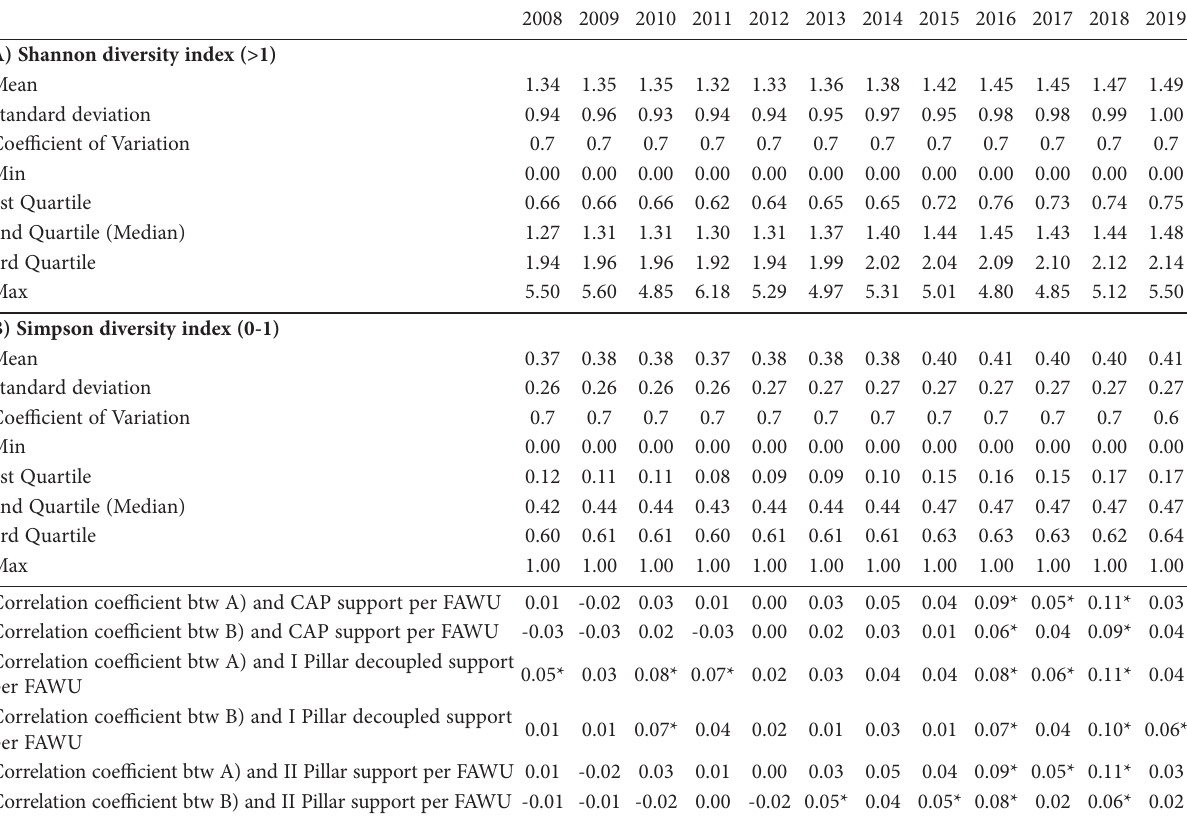
Table 4. Evolution of the Shannon and Simpson diversity indexes within the Italian 2008-2019 FADN balanced